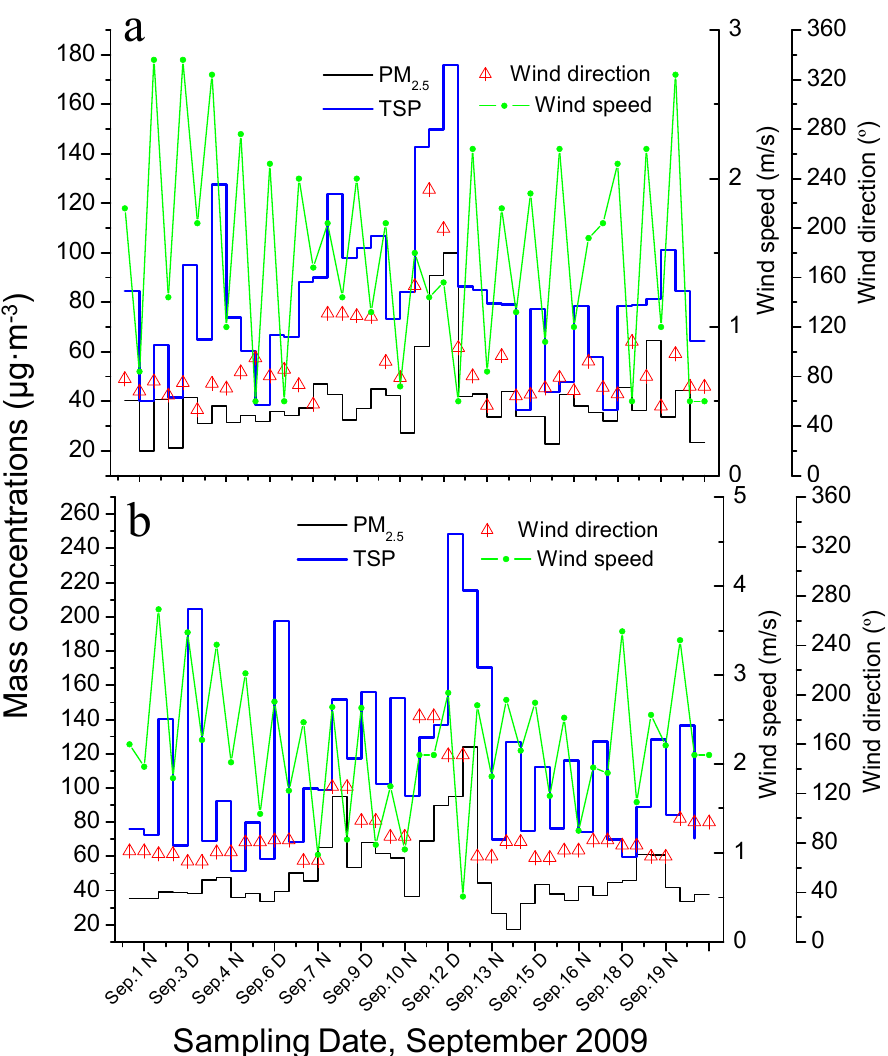
Figure 2. The concentrations of PM 2.5 and TSP vs the wind speed and wind direction during daytime and nighttime. ( a ) Pudong, ( b )